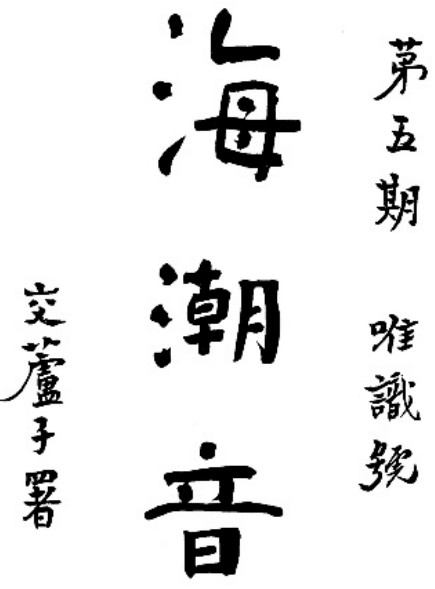
Figure 2. A cover of The Sound of the Sea Tide .